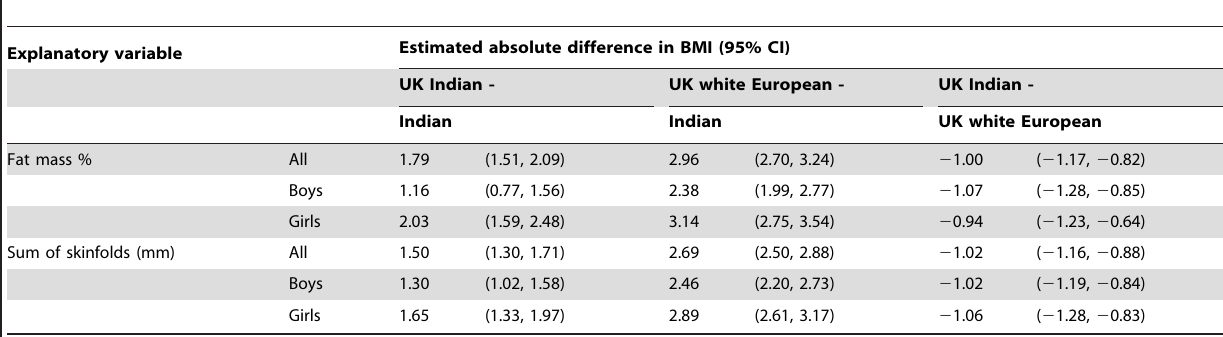
Table 3. Estimated population differences in BMI at median adiposity (fat mass % or sum of skinfolds) levels in whole study population: for all children and by